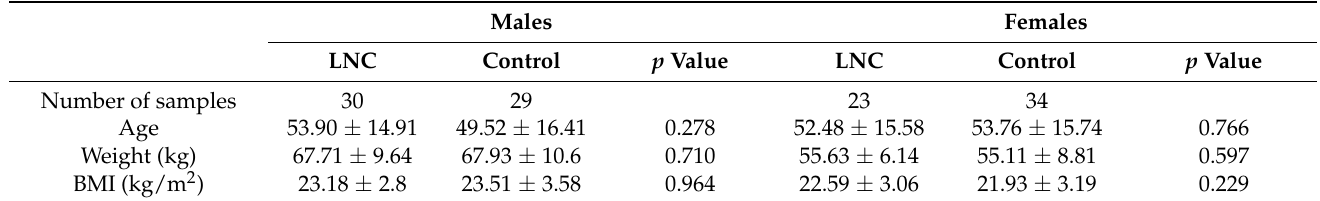
Table 1. Characteristics of the study population at the beginning of the study (Day 0).